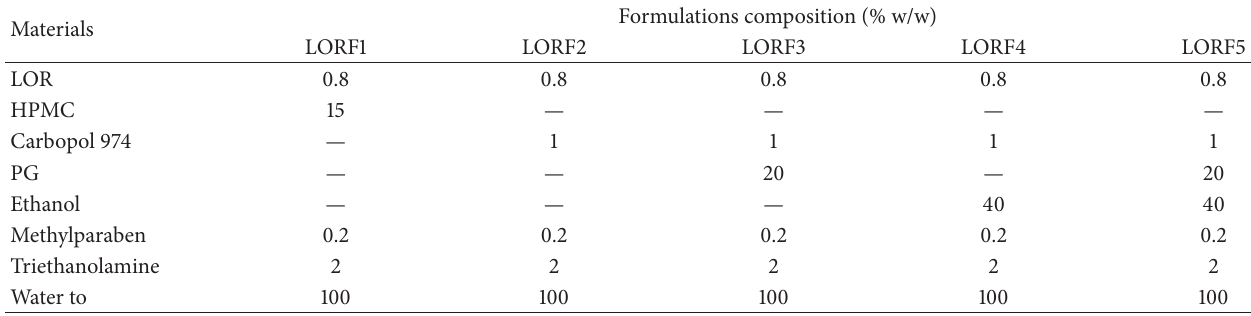
Table 1: Composition of LOR gel formulations.